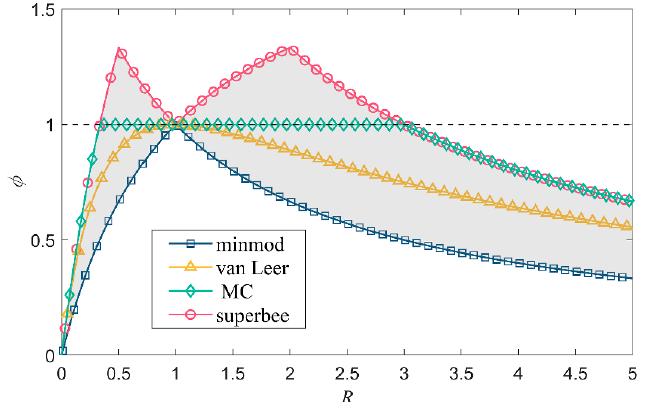
Figure 5. Diagram of slope limiters in this study. The shaded region represents the second-order TVD